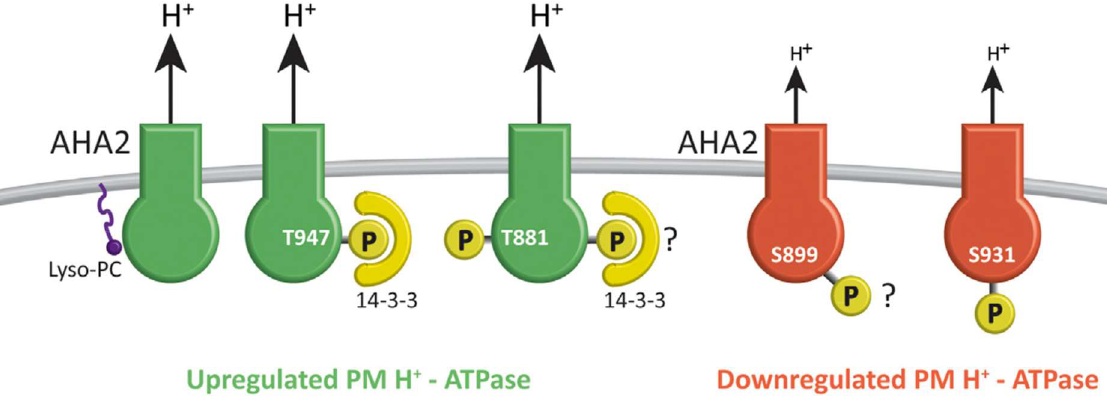
Figure 3. Posttranslational regulation of the PM H + -ATPase alternates between two states: reprinted from [38]. Red = downregulated pumps hydrolyze ATP with low efficiency, hence the low transport of H + . Green = upregulated pumps with high ATPase efficiency, and high H + transport rates. C-terminal regulatory domains control transition between the two states. The phosphorylation (P) of the C-terminal penultimate threonine residue (Thr-947 in pump AHA2) creates a binding site for a 14-3-3 protein that stabilises the pump. The binding of lysophosphatidylcholine (Lyso-PC) and phosphorylation at Thr-881 also activates the PM H + -ATPase independently of phosphorylation and 14-3-3 protein binding. It is not known whether phosphorylation at Thr-881 in the C-terminal domain interferes with or depends on 14-3-3 binding (as indicated by the question mark). Phosphorylation at Ser-899 or Ser-931 inactivates the pump. Phosphorylation at Ser-931 blocks the binding of 14-3-3 protein, but is not known for Ser-899. Only well-characterized regulatory events are shown.